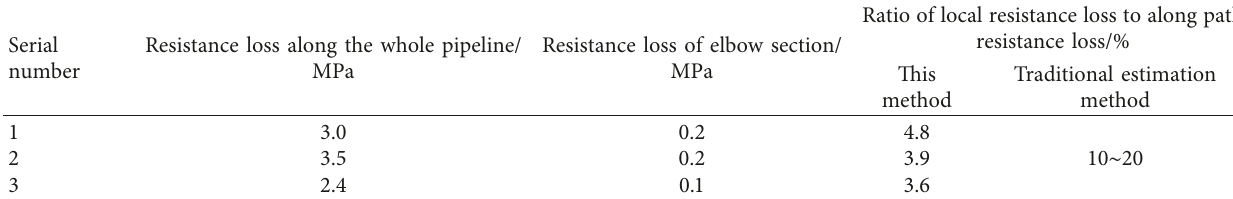
Table 3: Comparison of local resistance loss in the pipeline between this method and the traditional